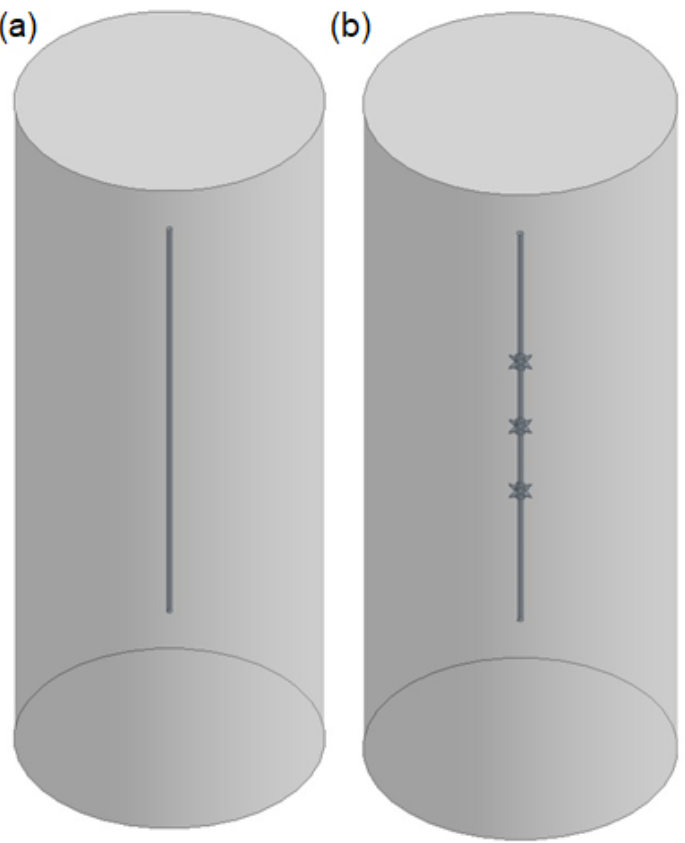
Figure 6. Simplified geometry used for simulations ( a ) without spike elements and ( b ) with spike elements.